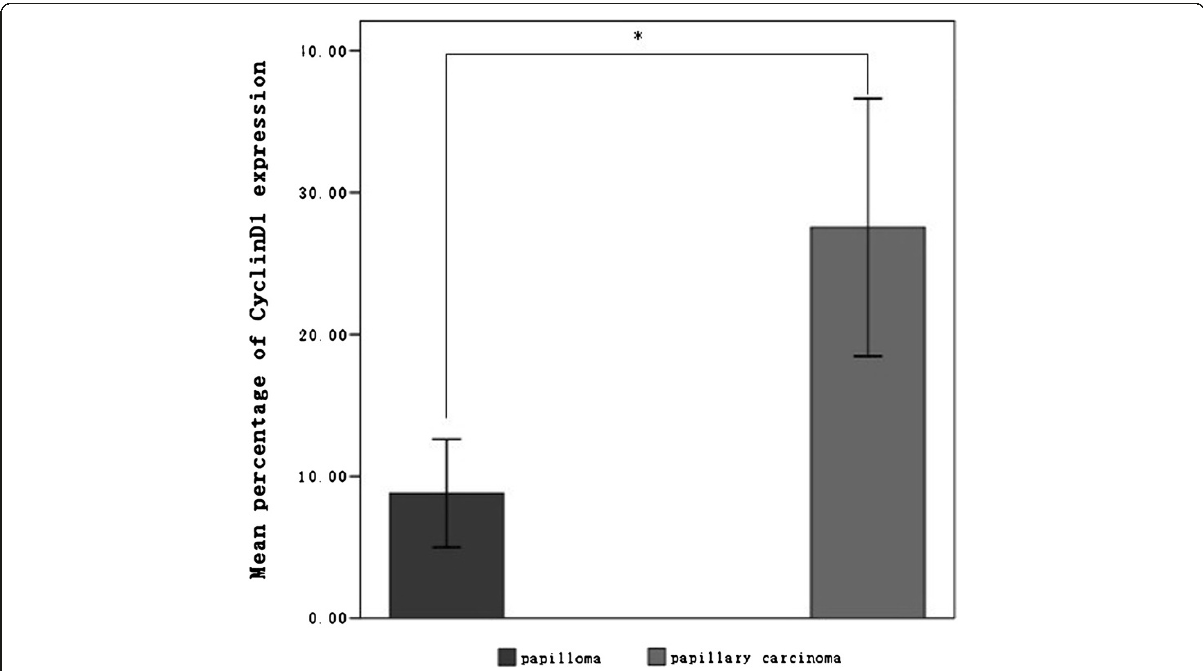
Figure 2 The mean expression rate of Cyclin D1 in the papillomas and the papillary carcinomas. The expression rate of Cyclin D1 is 27.54%± 15.43% in papillary carcinomas and 8.81% ± 8.41% in papillomas (p < 0.01). The values are expressed as (cid:1) X ±SD. *P < 0.01 (Mann – Whitney U test). The difference exhibited clear statistical